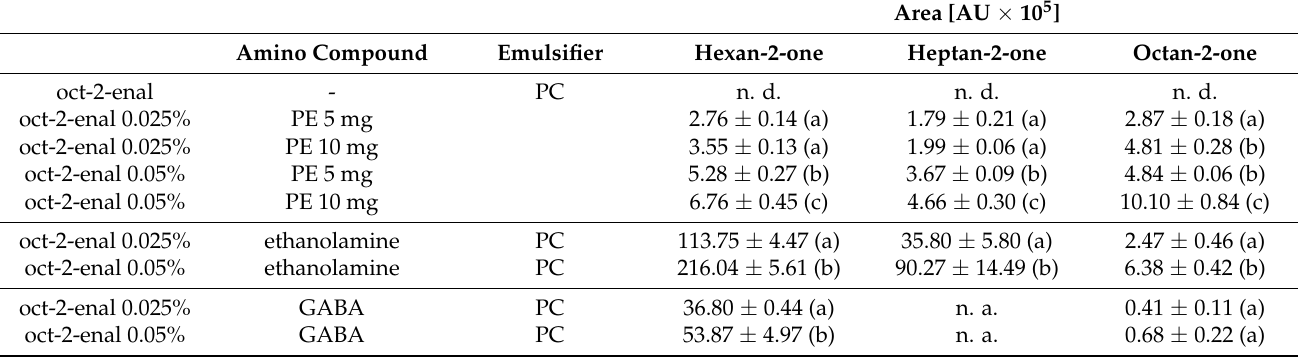
Table 7. Peak areas of methyl ketones from oct-2-enal (0.05 and 0.025% in paraffin oil) with PE or ethanolamine and PC or GABA and PC, heated at 160 ◦ C for 20 min and analyzed by HS-GC-MS; n. d. = not detected; n. a. = not analyzable, due to peak